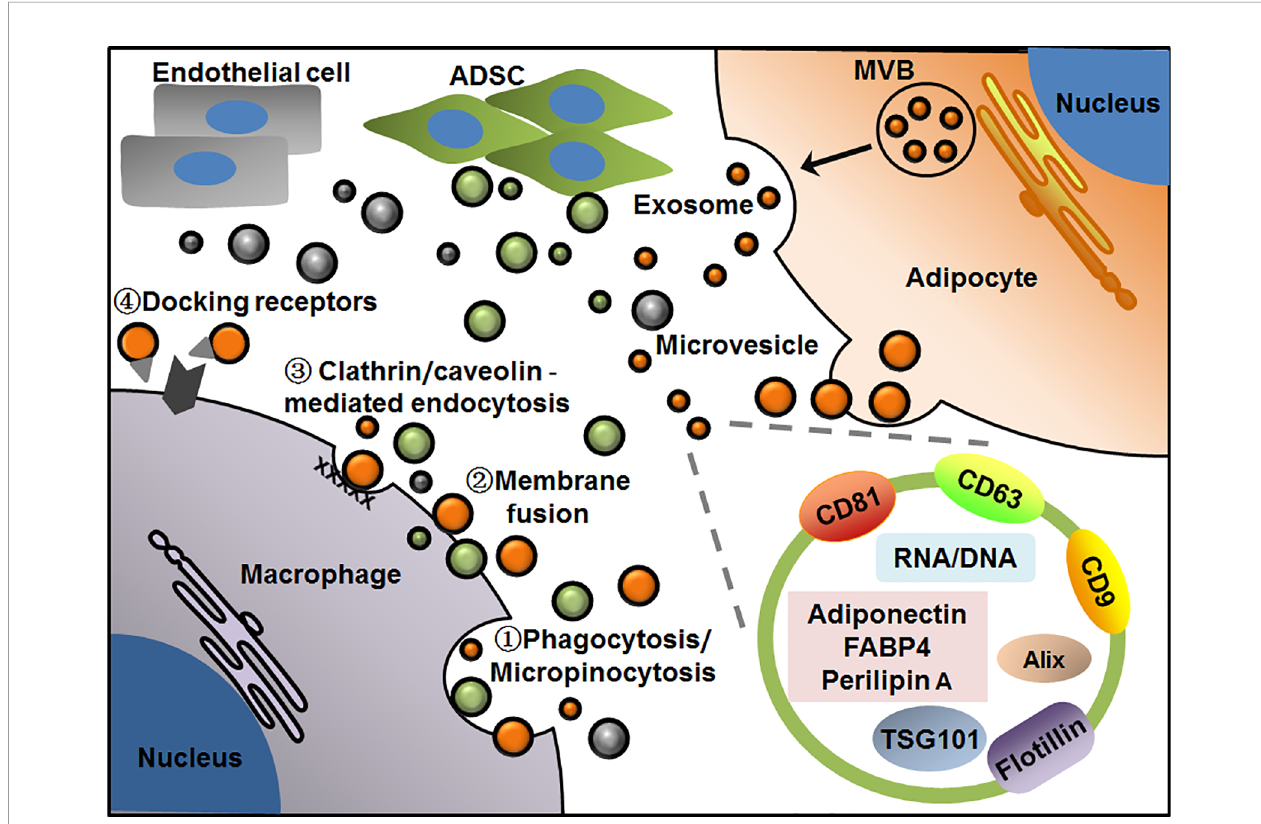
FIGURE 1 | Patterns of EV-mediated communication of adipocytes with macrophages in adipose tissue. Adipocytes release microvesicles and exosomes through outward budding of plasma membrane or exocytosis via MVB pathway, respectively. Macrophages take up EVs by phagocytosis/micropinocytosis ① , direct membrane fusion ② , clathrin/caveolin -mediated endocytosis ③ or binding with particular docking receptors ④ . Adipocyte-derived exosomes display general markers such as CD81, CD63, CD9, Alix, TSG101 and fl otillin, as well as several cell-speci fi c molecules such as adiponectin, FABP4 and perilipin A. EVs from adipocyte, ADSC or endothelial cell are presented in orange, green and gray,